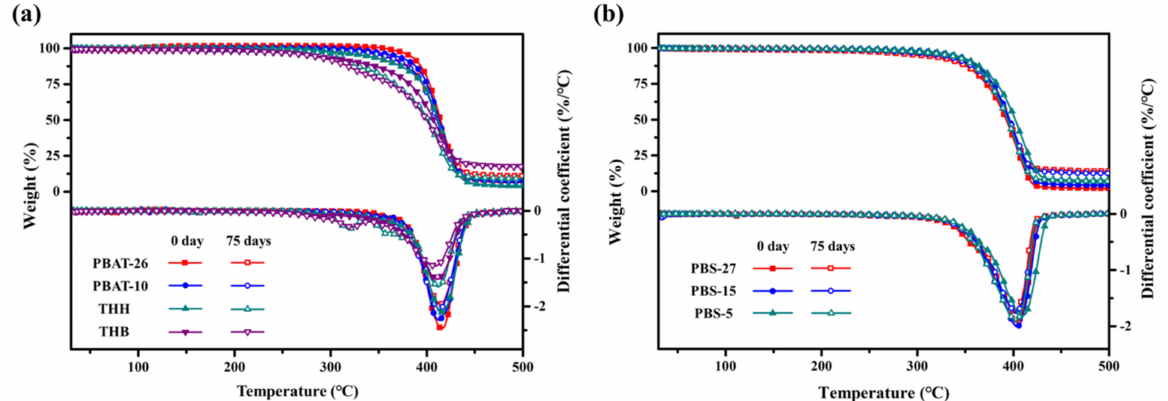
Figure 2. TGA curves of ( a ) PBAT and ( b ) PBS mulching films before and after a 75 − day